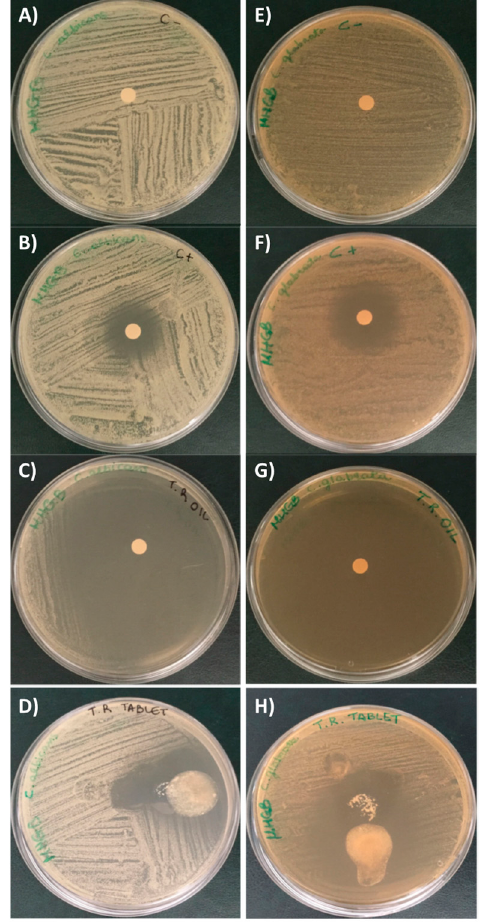
Figure 4. Growth inhibition halo (disk diffusion test) induced by T. vulgaris on C. albicans and C. glabrata . ( A ) C. albicans negative control (1,4-dioxane); ( B ) C. albicans positive control (clotrimazole); ( C ) T. vulgaris essential oil against C. albicans ; ( D ) Tablet against C. albicans ; ( E ) C. glabrata negative control (1,4-dioxane); ( F ) C. glabrata positive control (clotrimazole); ( G ) T. vulgaris essential oil against C. glabrata ; ( H ) Tablet against C. glabrata .